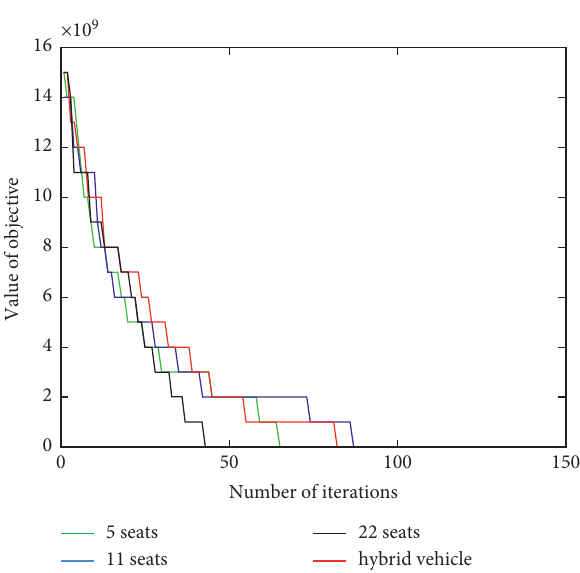
Figure 9: Comparison of iterative curves between hybrid types and single